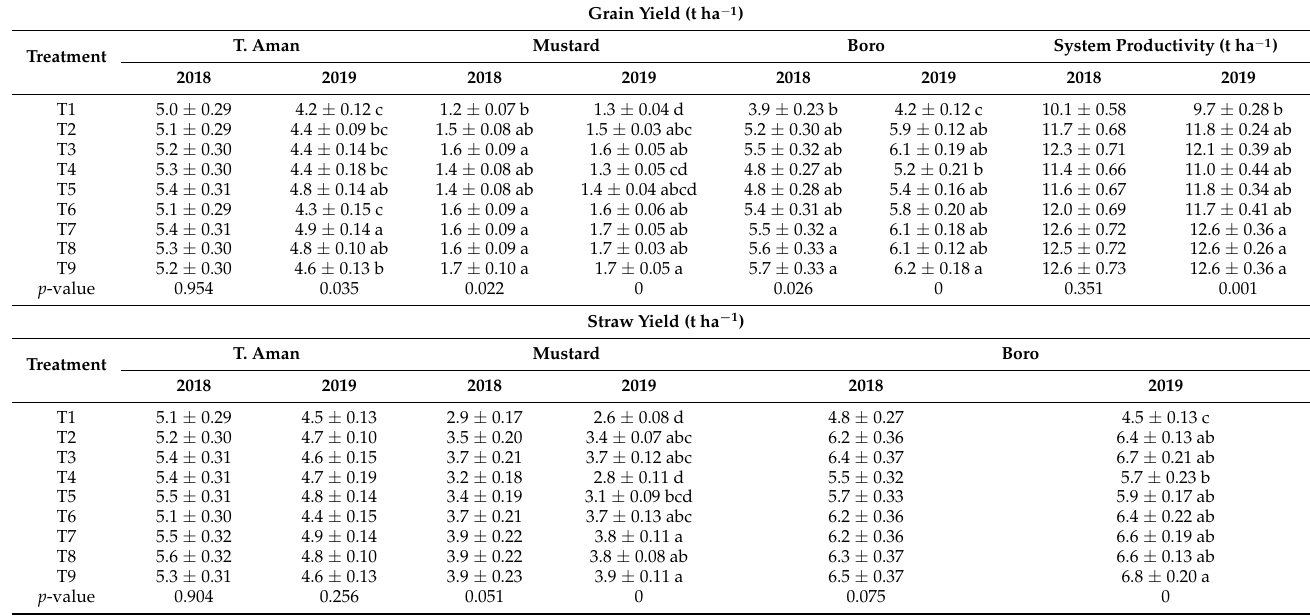
Table 3. Effect of lime and manure amendment on grain yield, straw yield and total system productivity of T. Aman– Mustard–Boro cropping pattern.